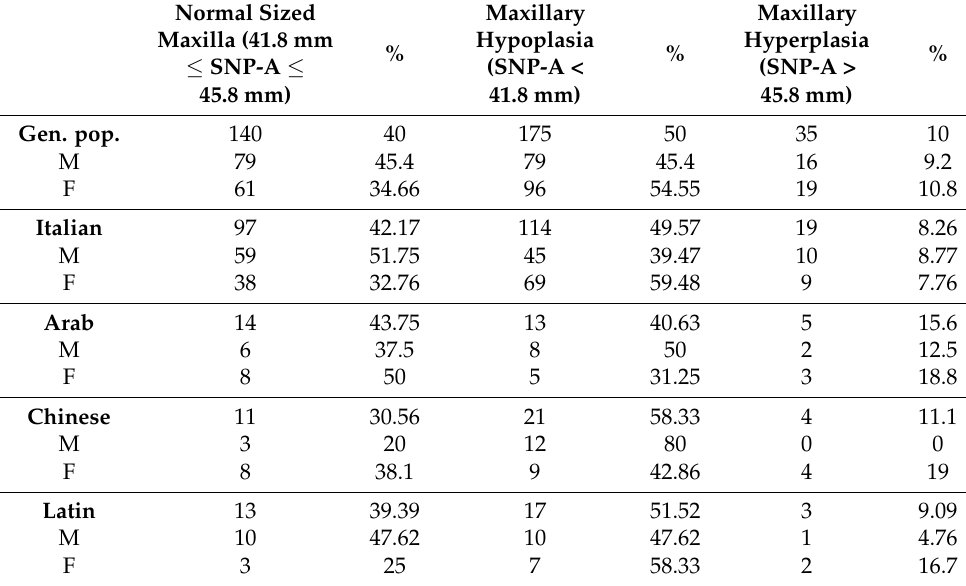
Table 6. Distribution of maxillary bone size values in the selected patient